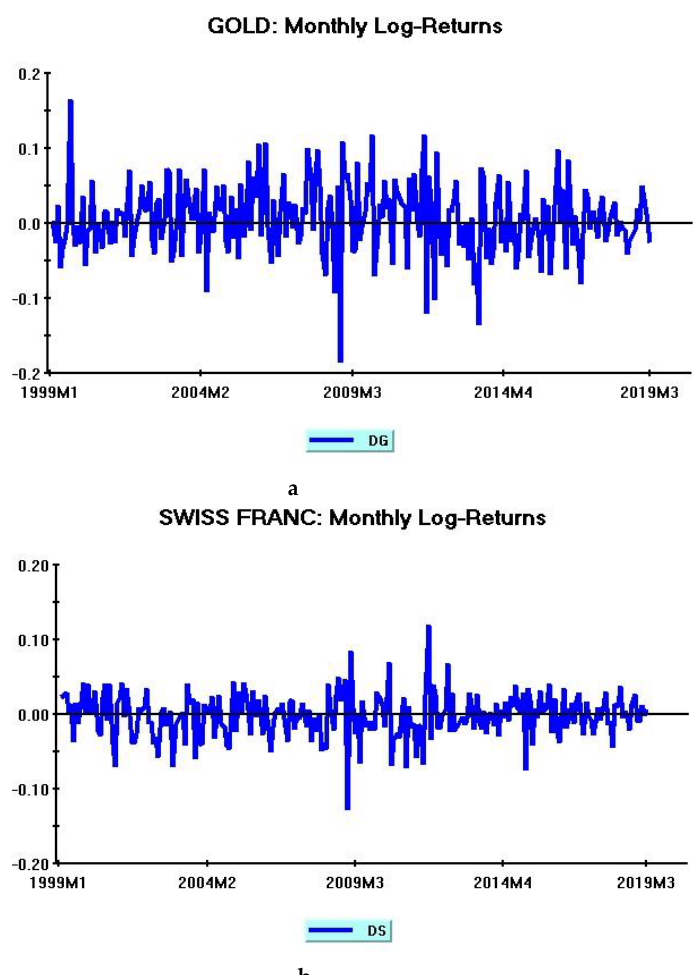
Figure 3. ( a ) GOLD: Monthly Log-Returns; ( b ) SWISS FRANC: Monthly Log-Returns.